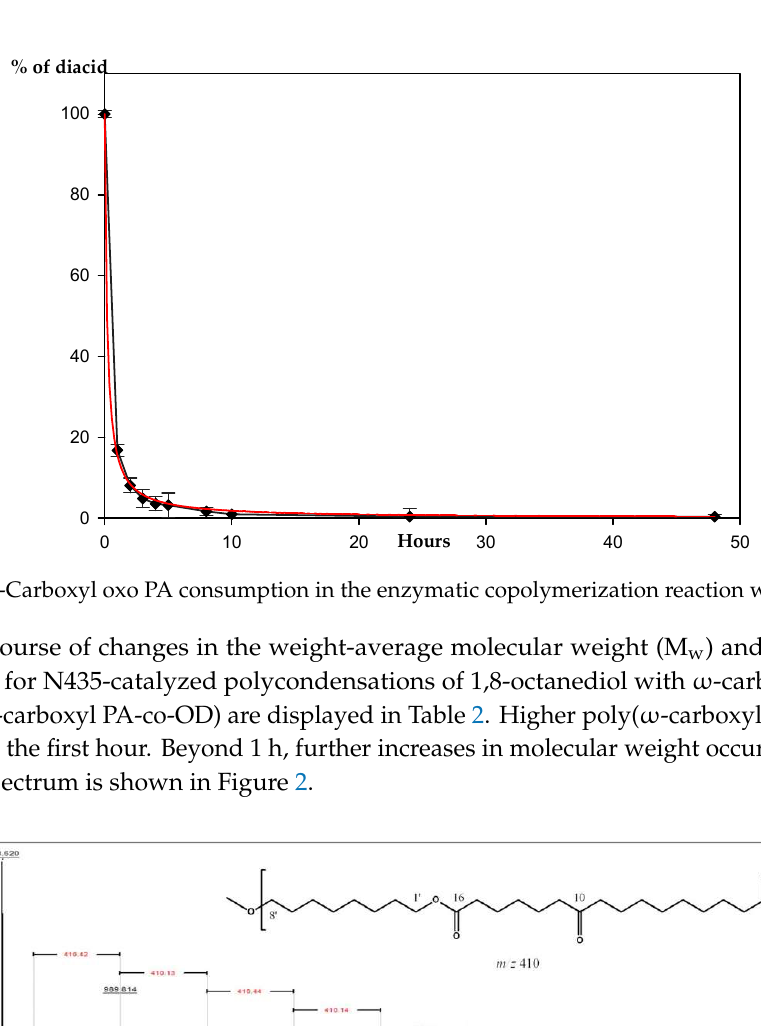
Table 2. M w , M n and PDI (Mw/Mn) Values for copolymerization of ω-carboxyl oxo PA and 1,8- octanediol using Novozyme 435.